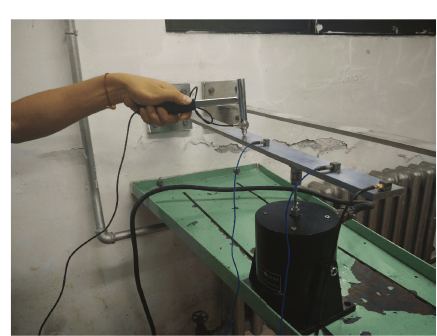
Figure 22: GCV in experiment of SISO system.